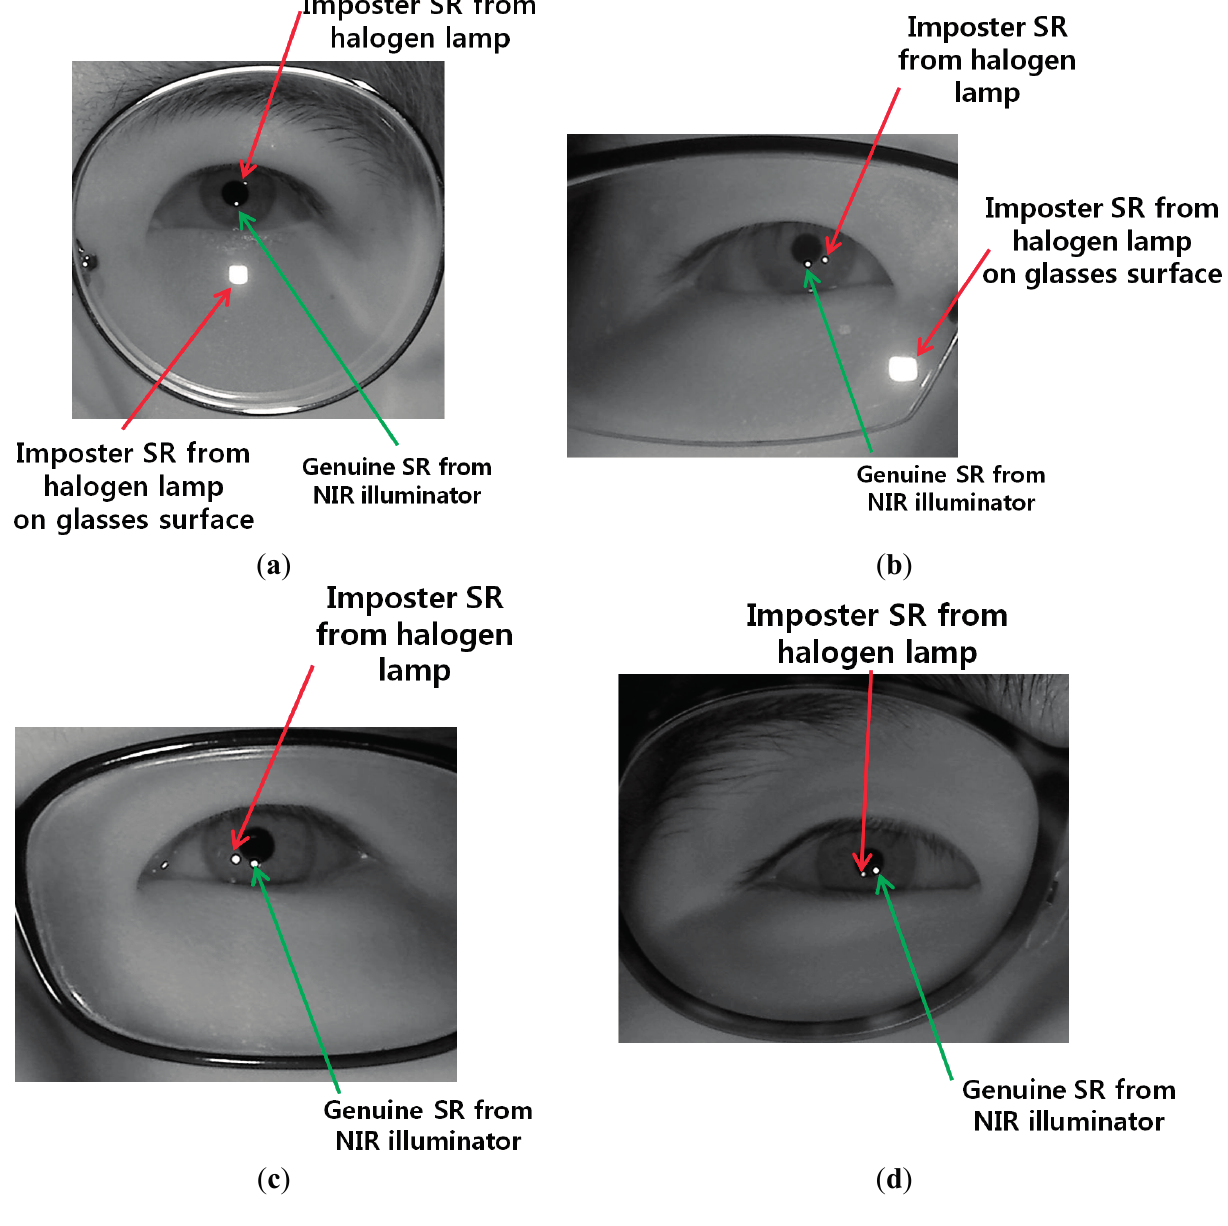
Figure 28. Examples of users wearing glasses. ( a ) user 1 with the halogen lamp above monitor display; ( b ) user 2 with the halogen lamp at the right of monitor display; ( c ) user 3 with the halogen lamp at the left of monitor display; ( d ) user 4 with the halogen lamp below monitor display. Table 3. The percentage of correctly labeled image of genuine SR versus total number of image in case of five people wearing glasses (unit: